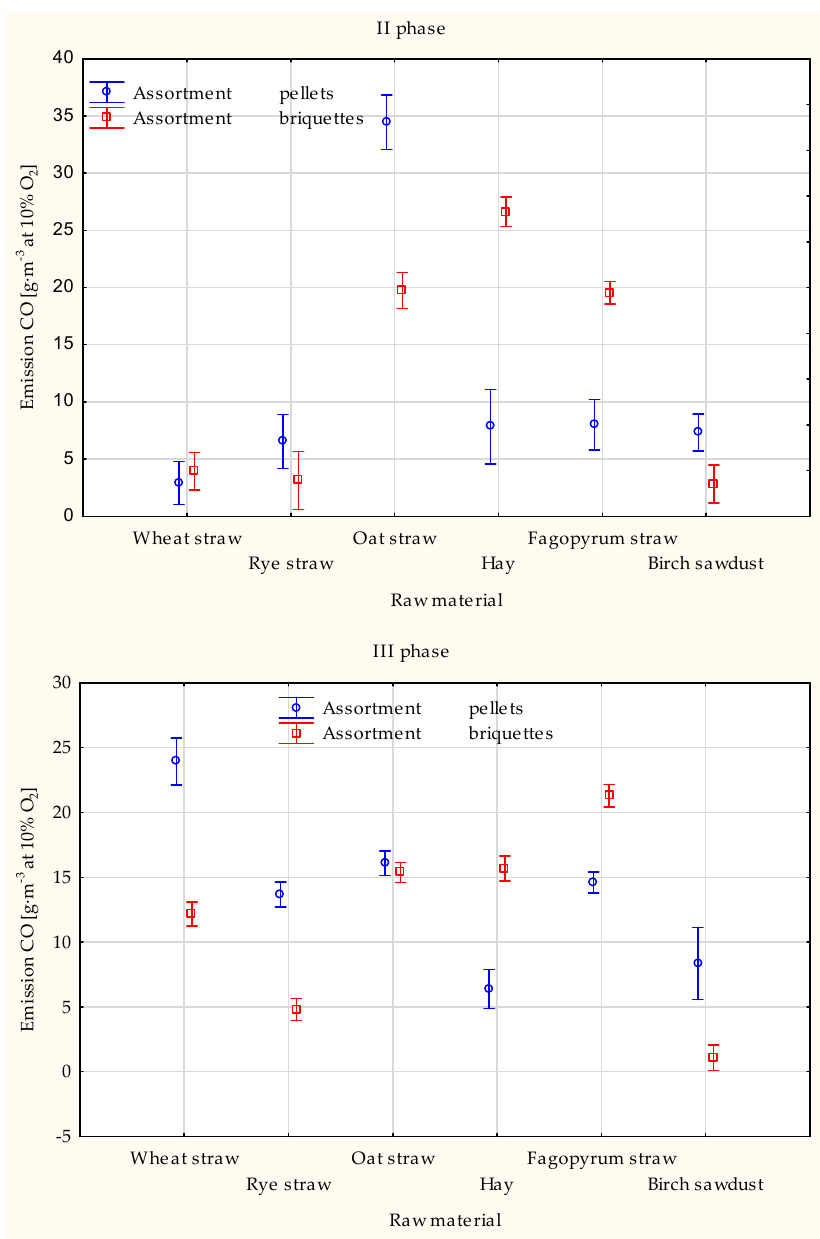
Figure 2. Emission CO in I, II and III phase combustion.